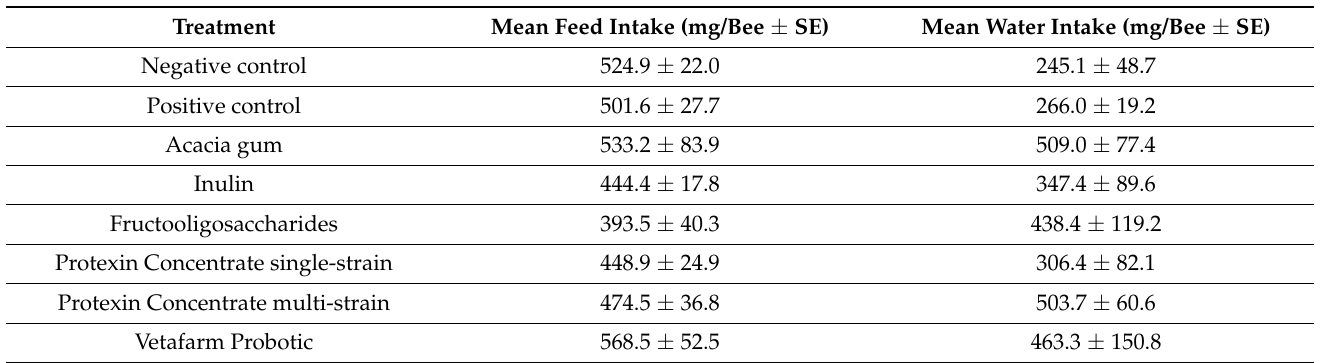
Table 4. Mean feed and water intake ± SE (mg of syrup or water/bee in 16 days) of non-infected (negative control)